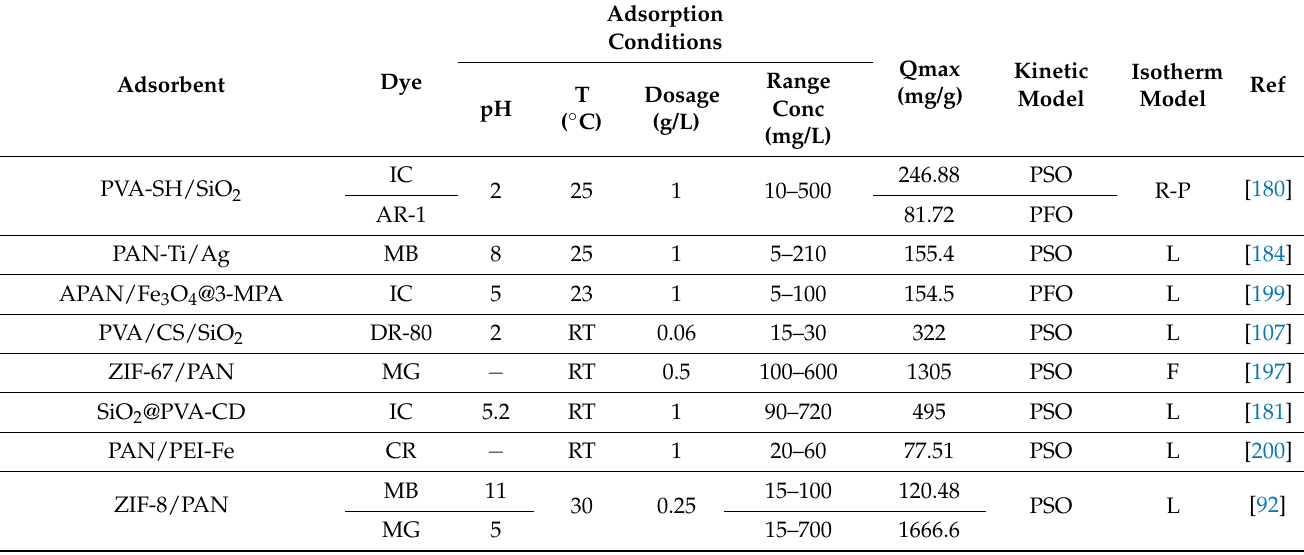
Table 7. EPNFs/silica, EPNFs/metal oxides and EPNFs/metal organic frameworks (MOFs) nanocomposites as adsorbent for the removal of